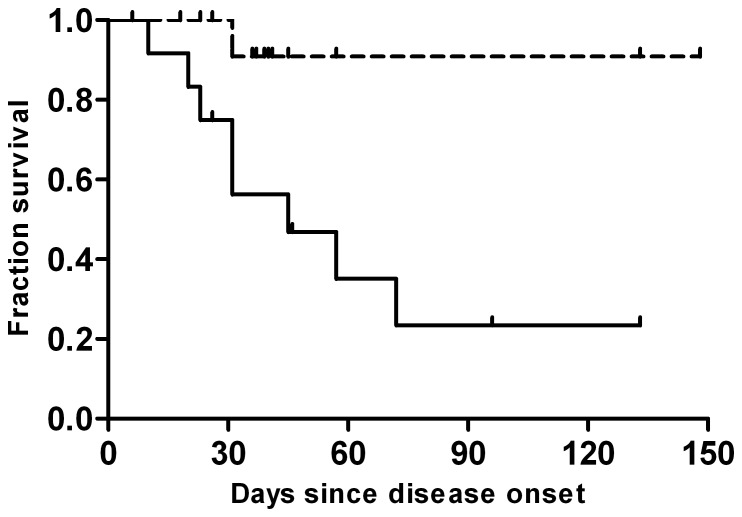
Survival plot for cases aged <60 years (dashed line), compared with cases aged ≥60 years(solid line), by duration since onset of illness.